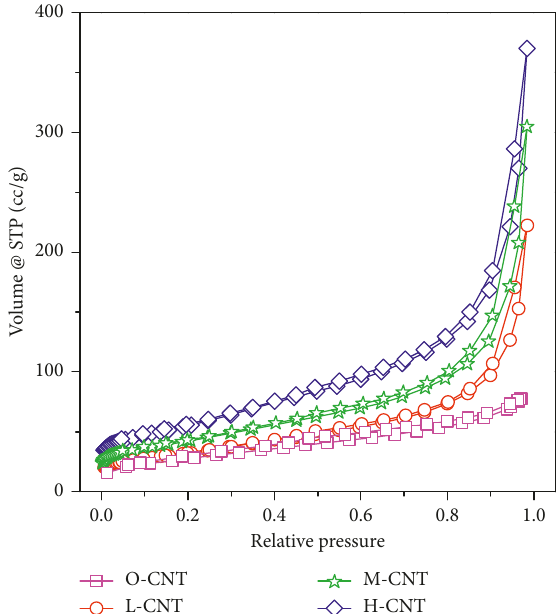
Figure 1: N 2 adsorption/desorption isotherms at 77 K corresponding to the